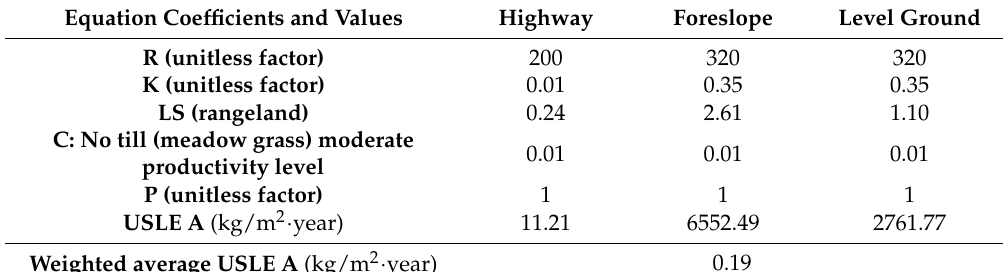
Table 1. Universal Soil Loss Equation (USLE) values and factors for the idealized catchment area. Equation Coefficients and